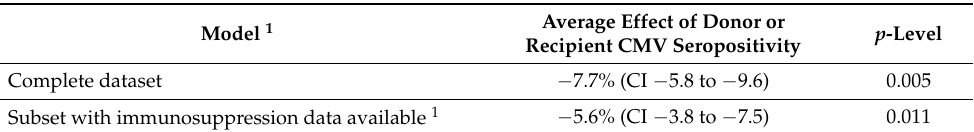
Table 5. Propensity score matched models. Patients with CMV recipient or donor seropositive status donor or recipient were significantly less likely to have normal functional status compared to matched-controls with the same propensity score.